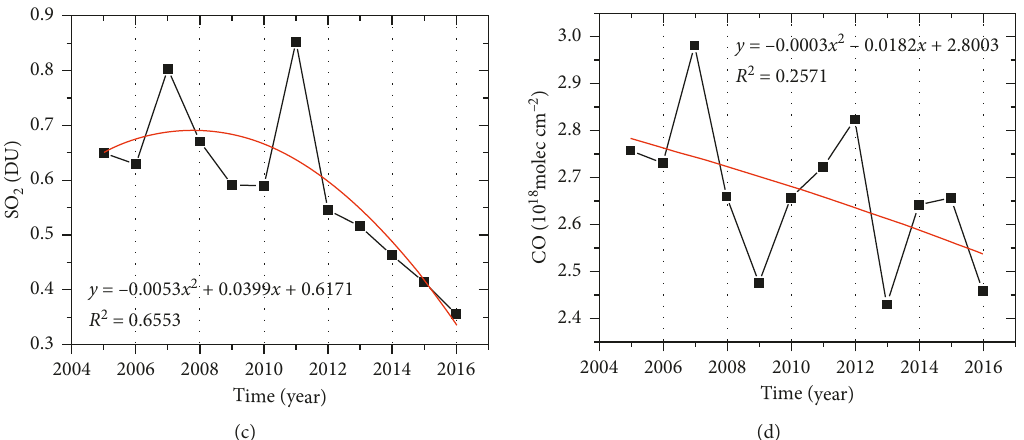
Figure 5: Time series of tropospheric column trace gas concentrations based on satellite observations for each summer during 2005–2016 in the NCP: (a) NO 2 , (b) HCHO, (c) SO 2 , and (d) CO. Each red line represents the fitting curve.